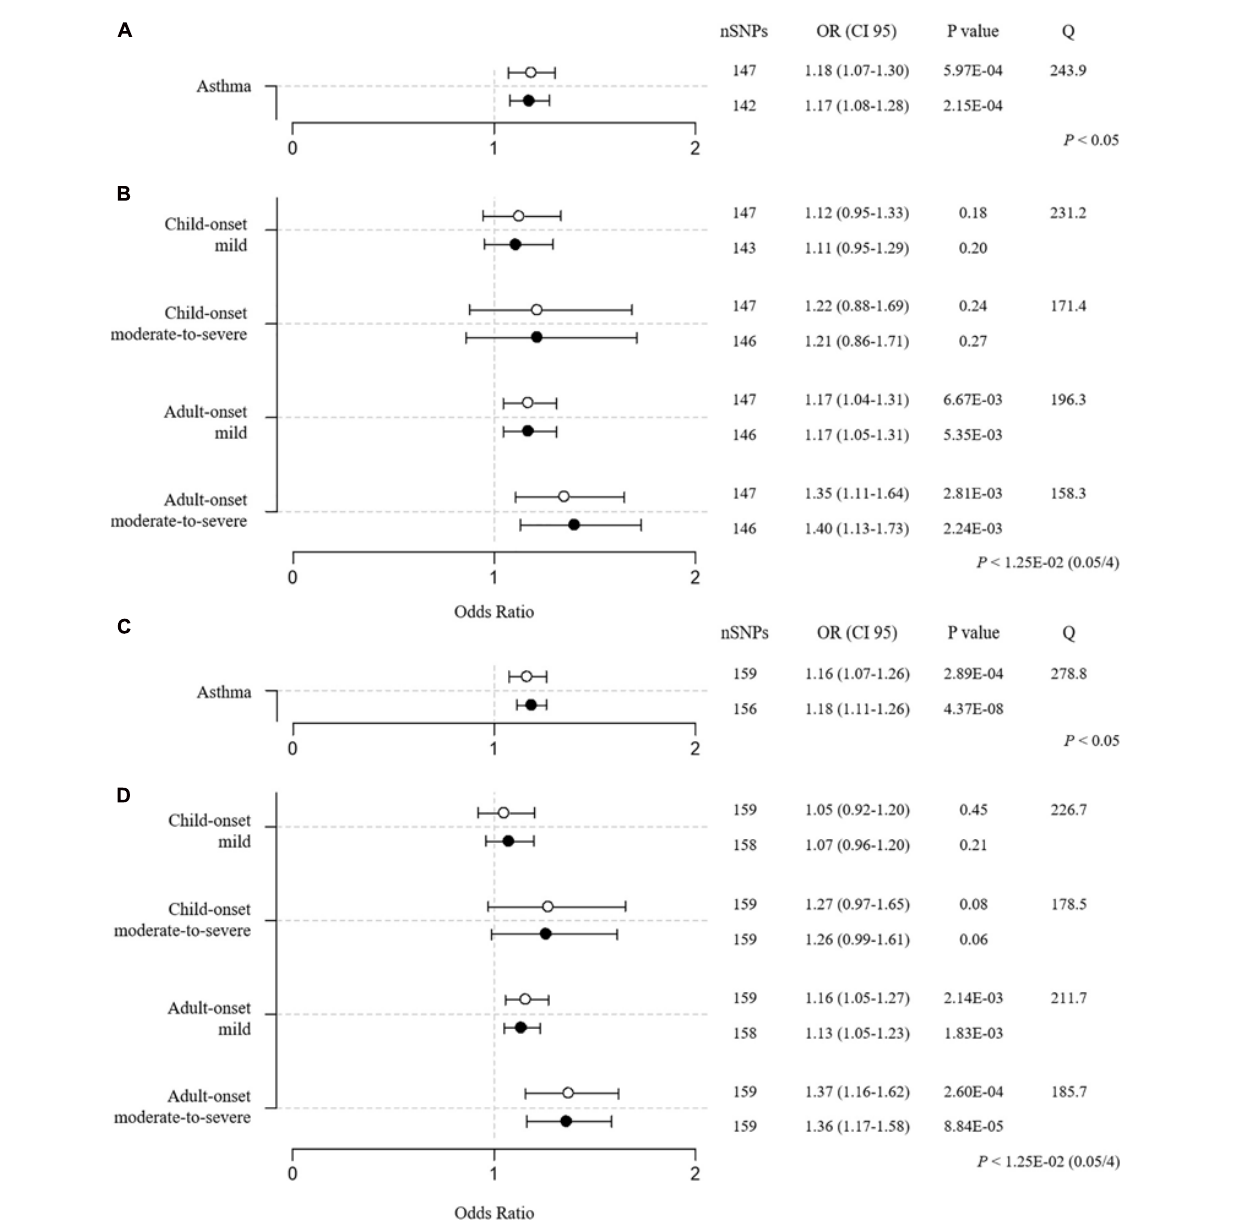
FIGURE 5 | Two-sample MR estimates of BMI → asthma (A,C) and BMI → 4 asthma subtypes (B,D) . (A,B) BMI SNPs were obtained from a meta-GWAS of Japanese (JBB) and European individuals (GIANT). (C,D) BMI SNPs were obtained from a GWAS that was performed in only controls (no asthma) from the UK Biobank. The IVW and GSMR methods are indicated by white and black dots, respectively. The Q value by Cochran’s Q statistic indicates residual heterogeneity in the MR